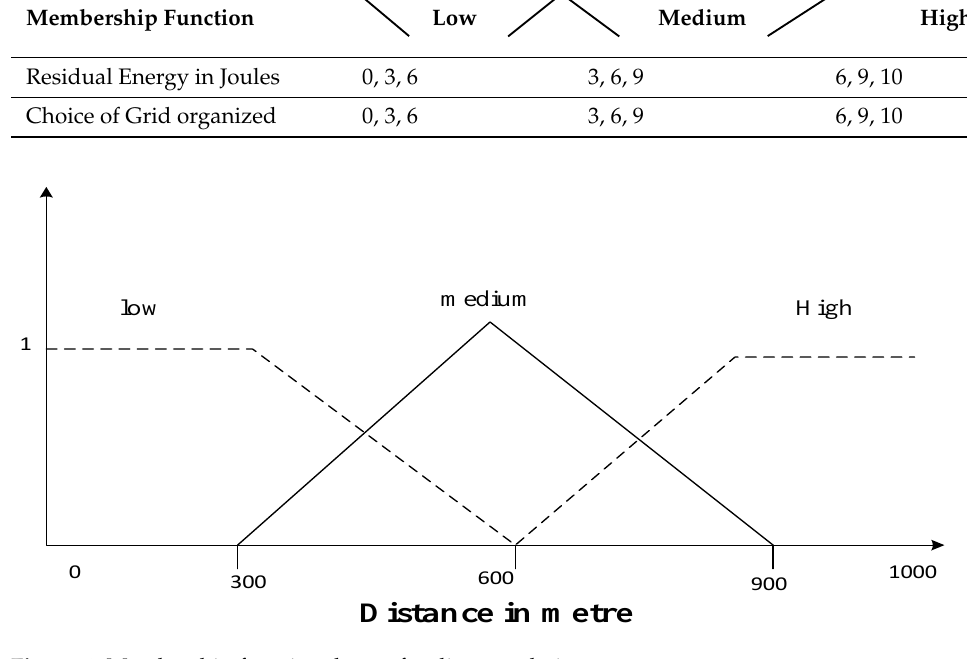
Table 2. Fuzzy rules for selection of grid organizer as relay node.